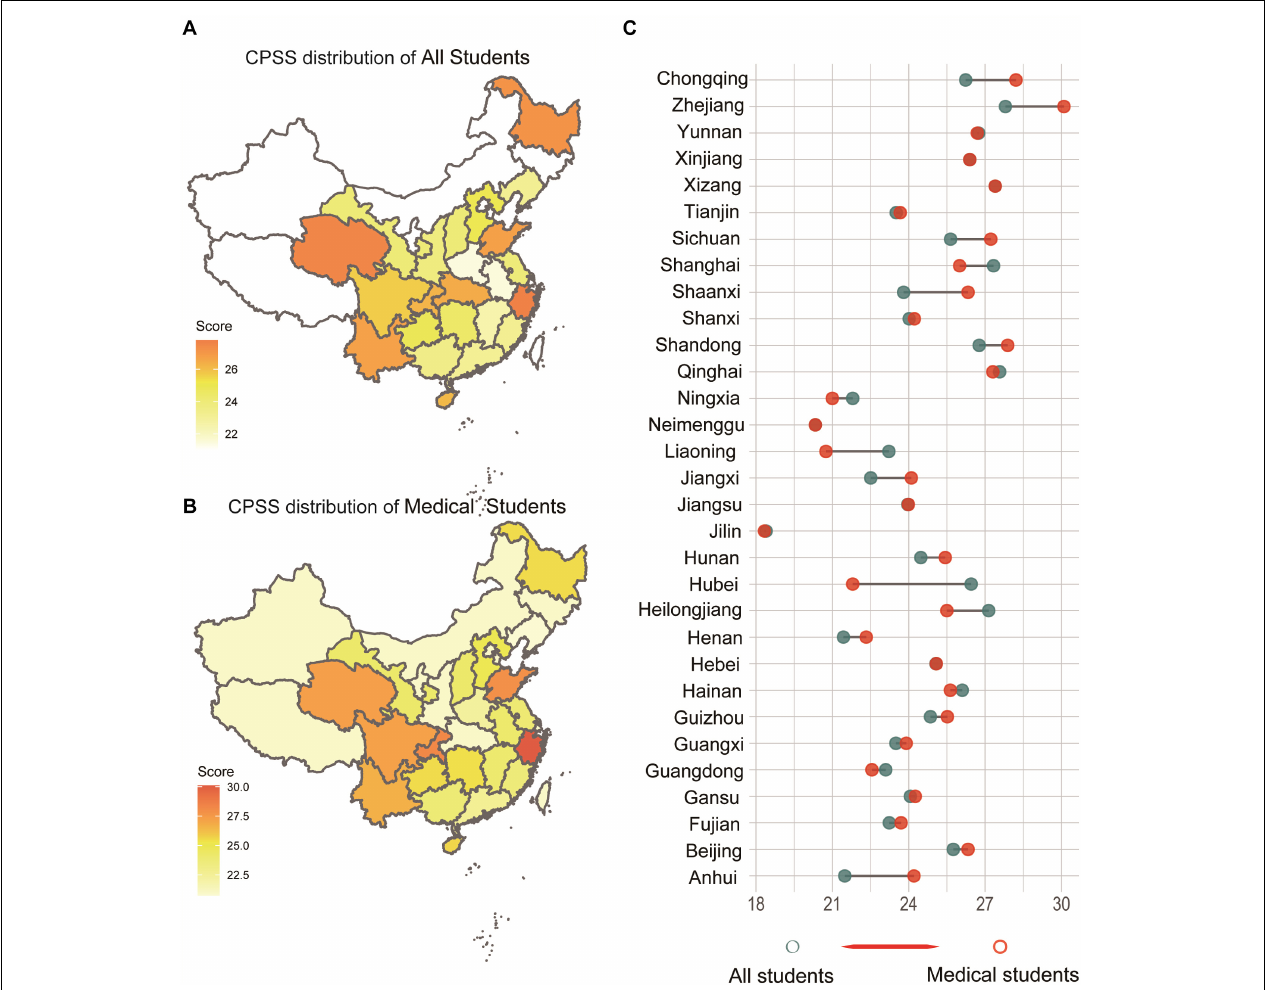
FIGURE 1 | The distribution and difference of the CPSS score of all students in each province of China. (A) The distribution of all students. (B) The distribution of the CPSS score of medical students. (C) CPSS score Changing from all students to medical students in each province of China.